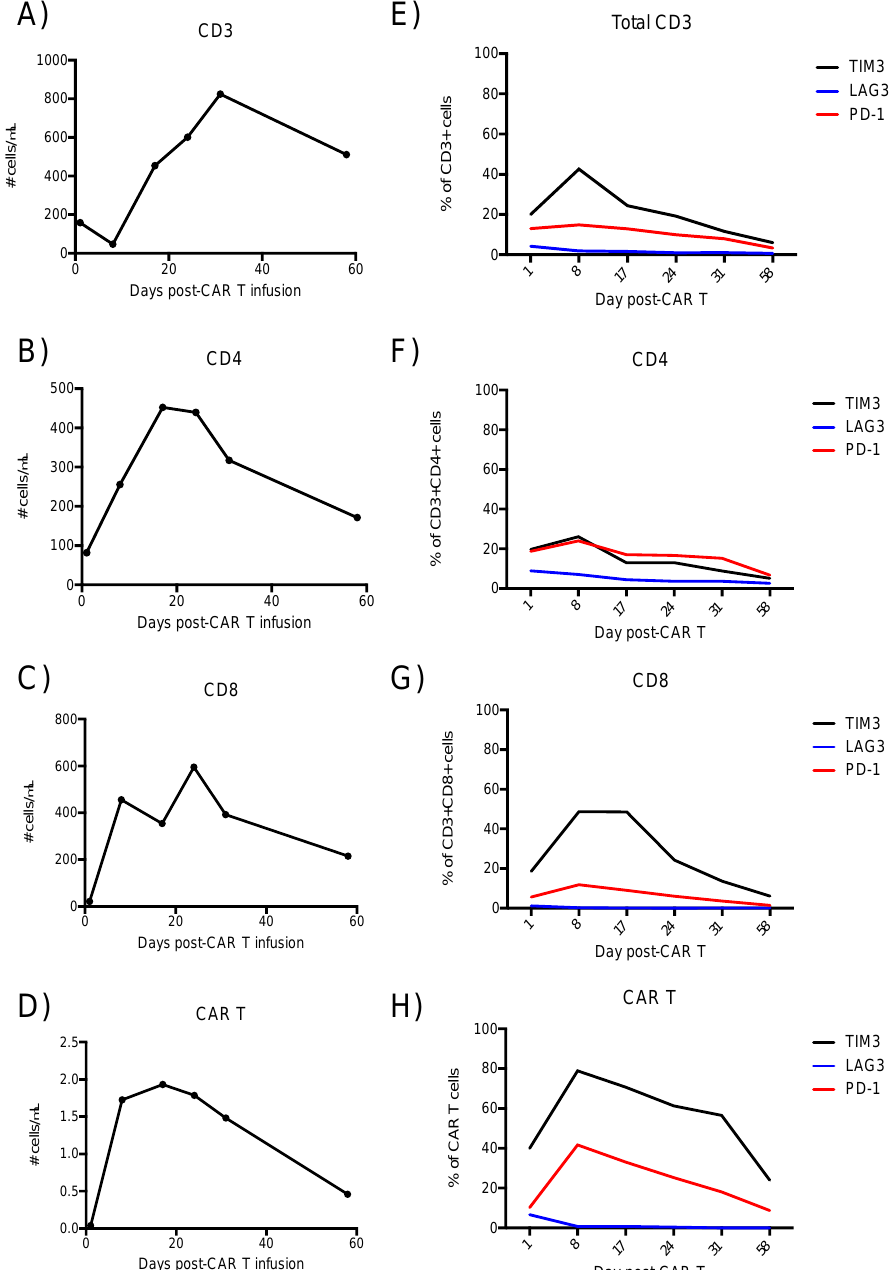
Figure 2. Transient expansion of T-cells and CAR T cells after tisagenlecleucel CAR T infusion. Panels A–D: Flow cytometry of PBMCs derived from peripheral blood, assessing expression of ( A ): CD3 ( B ): CD4 ( C ): CD8, and ( D ): CAR. Panels ( E – H ): Expression of immune checkpoint regulators on the T-cells over the same 58 days post-tisagenlecleucel infusion.